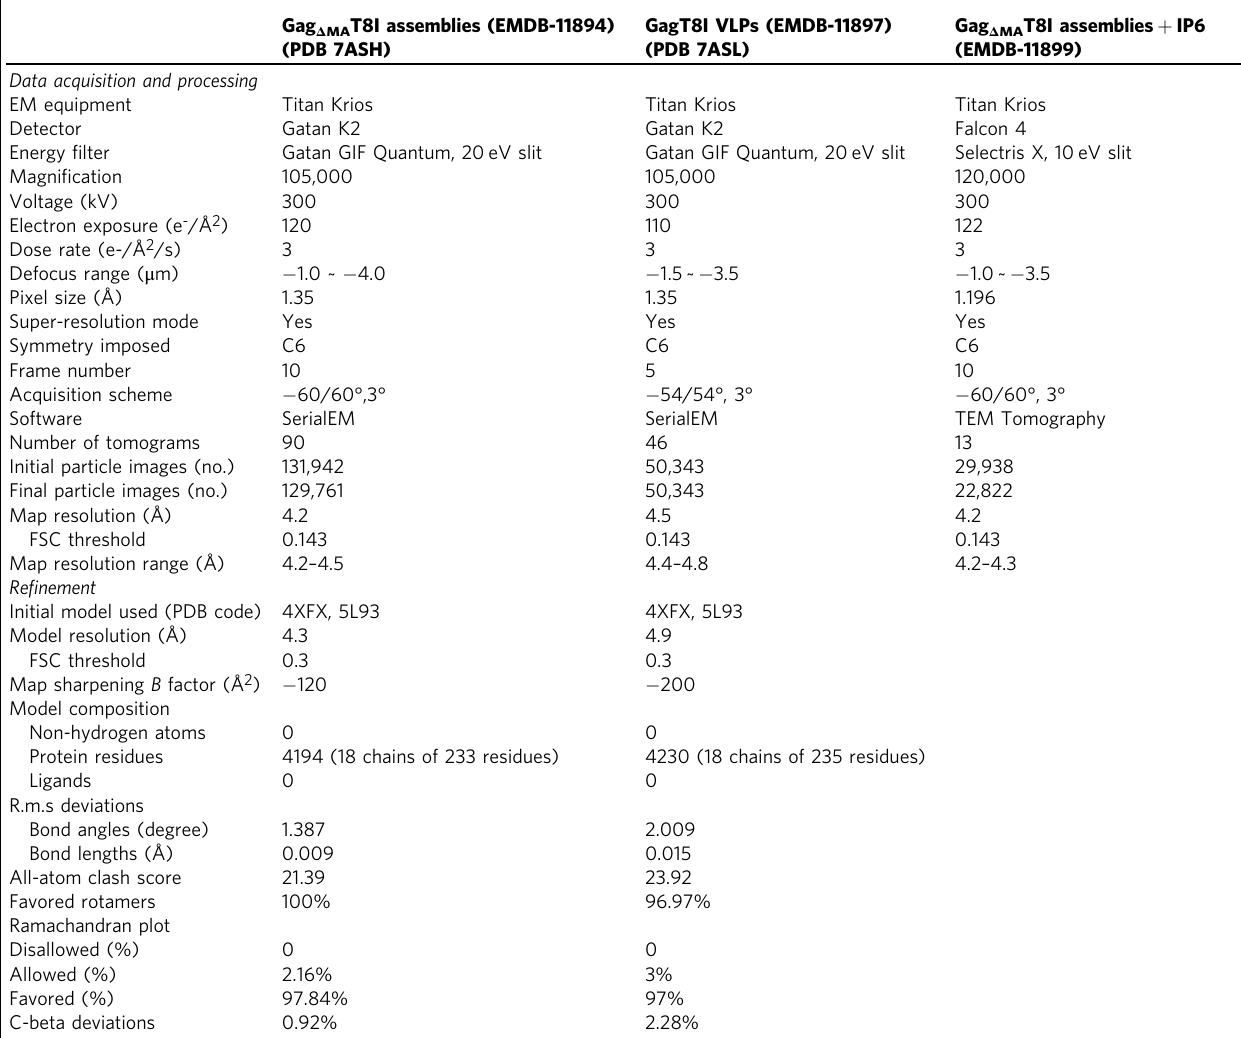
Table 1 Cryo-EM data collection, re fi nement and validation